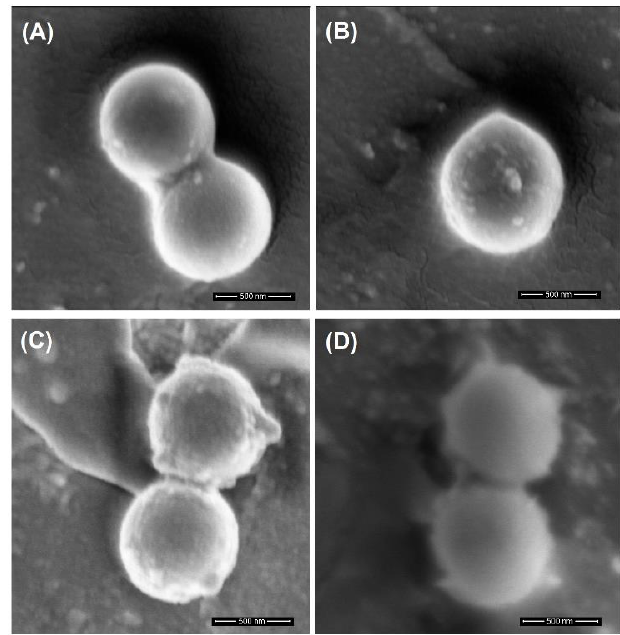
Fig. 5. SEM micrograph of the Si/SiO 2 spheres collected from the culturing media right after diatoms being added (A), after 1h (B), 2h (C) and 4h (D) cultivation.